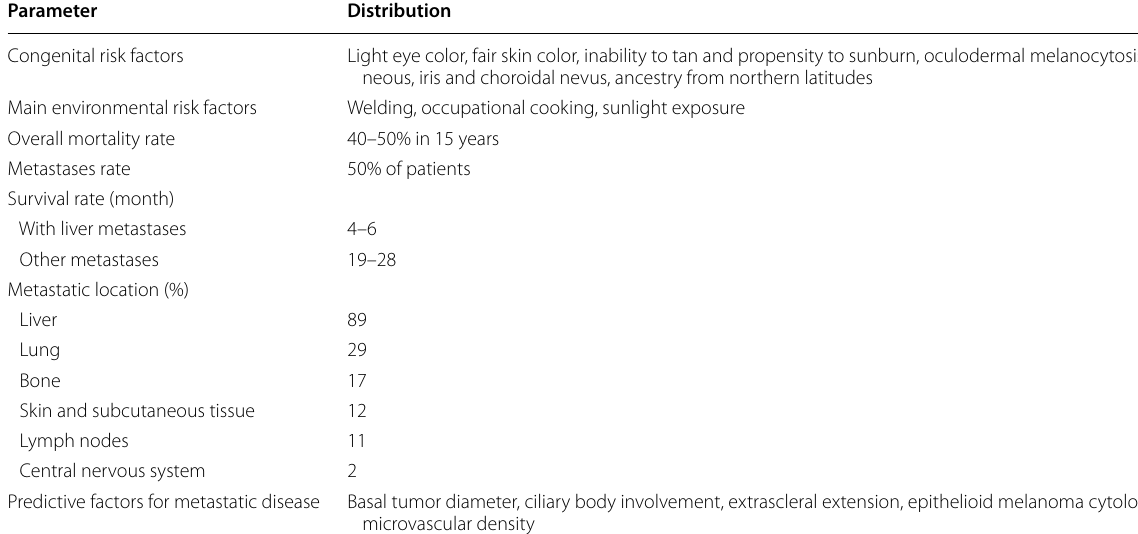
Table 2 Risk factors and other worth mentioning features of uveal